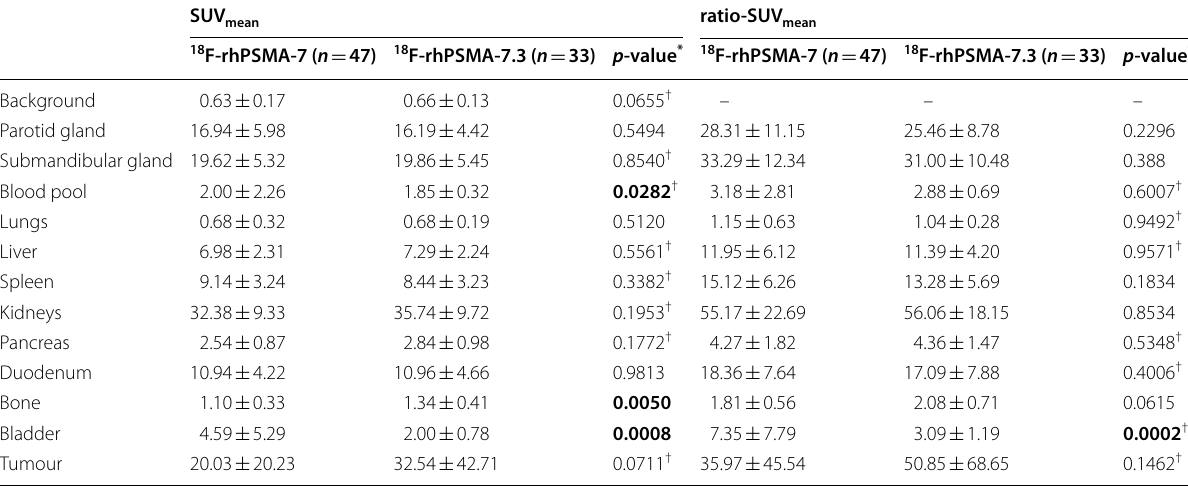
Bold indicate that this are significant p -values (below